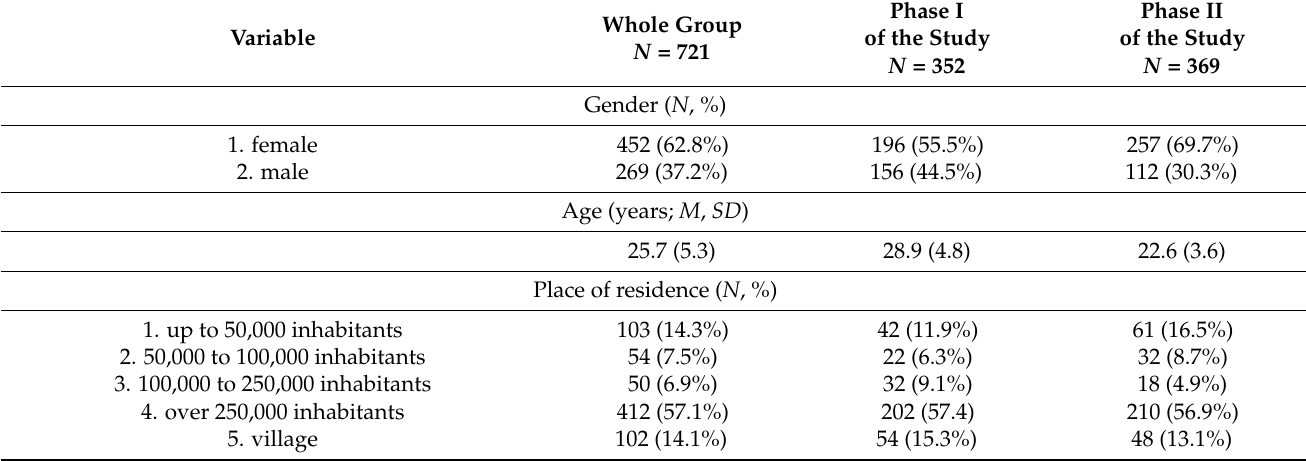
Table 1. Socio-demographic characteristics of the study